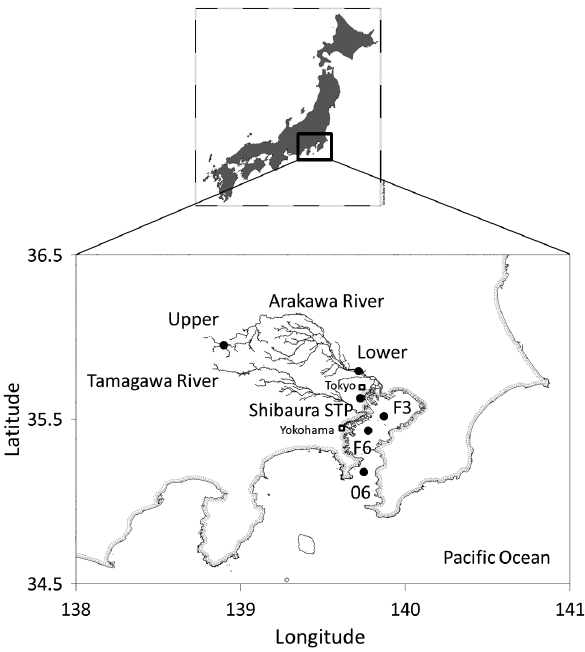
Figure 1. Map of Tokyo Bay. Locations of sampling sites are indi- cated by black